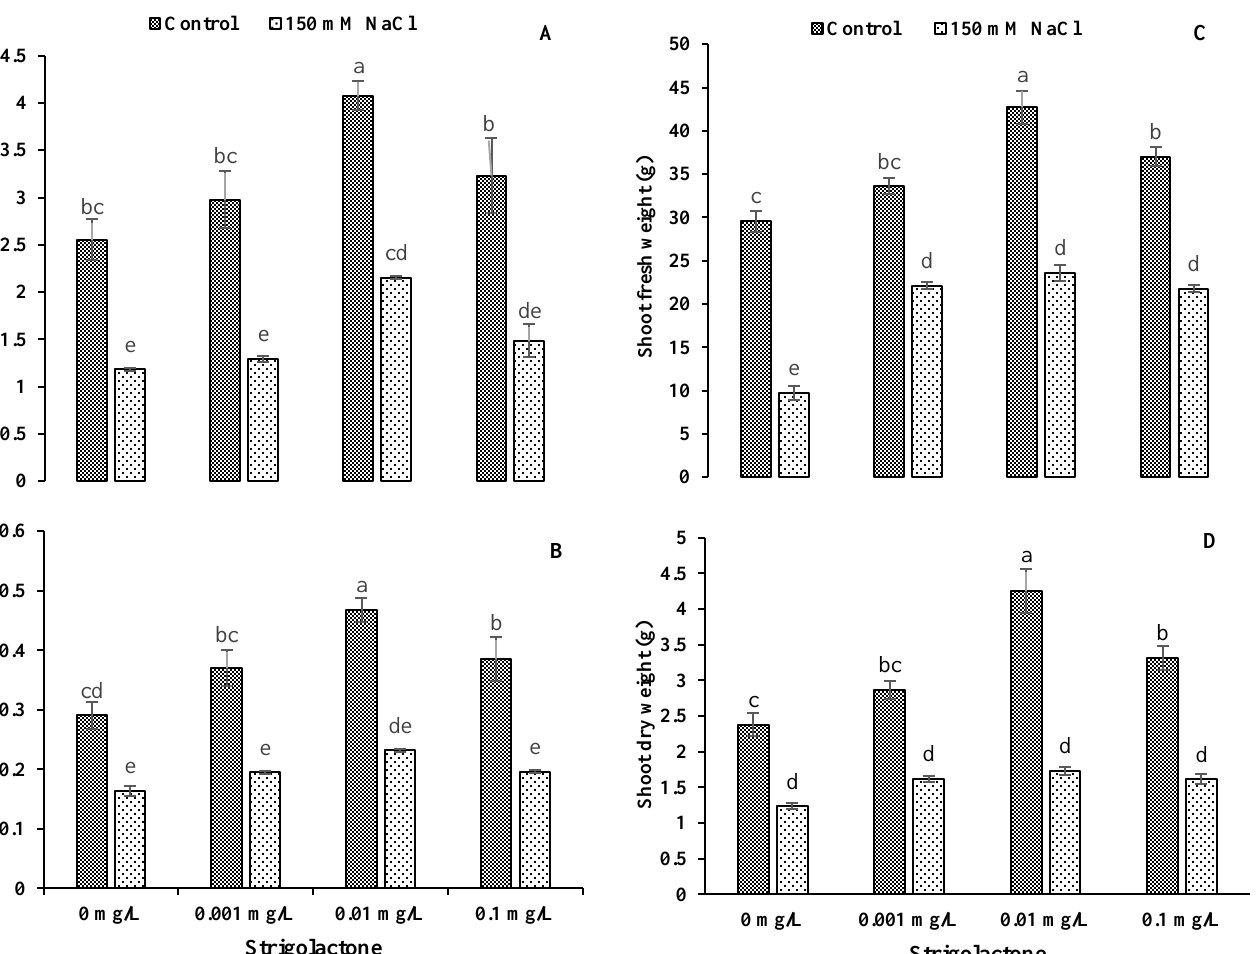
Table 2. Analysis of variance (ANOVA) for different mineral ions and plant biomass characteristics of ornamental sunflower with various GR24 levels (0, 0.001, 0.01 and 0.1 mg L −1 ) under saline and non-saline conditions.